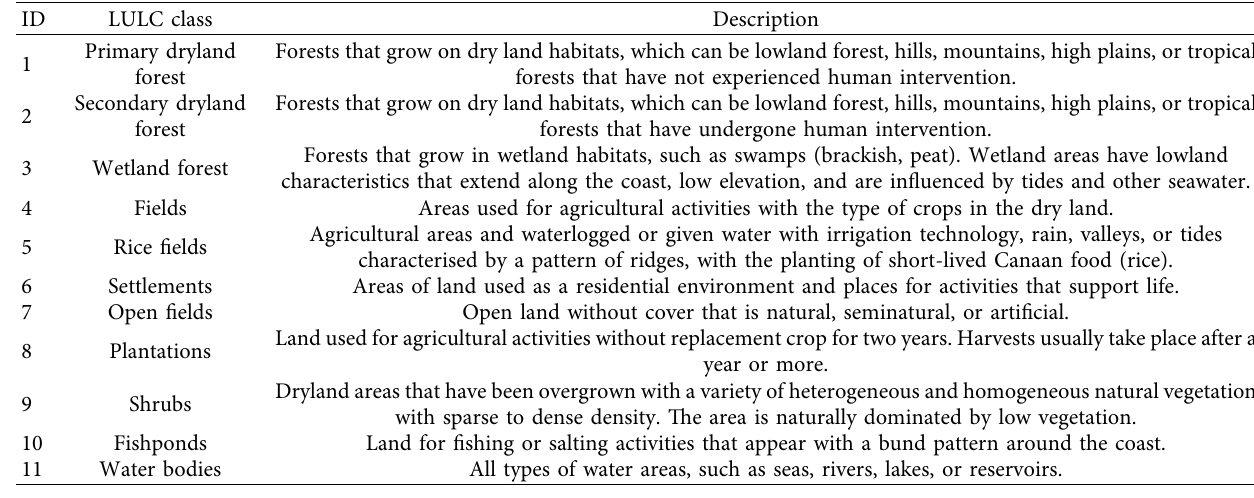
Figure 2: Study flowchart. Table 1: Class for the LULC classification used in this study, referring to the National Standardization Agency for Indonesia